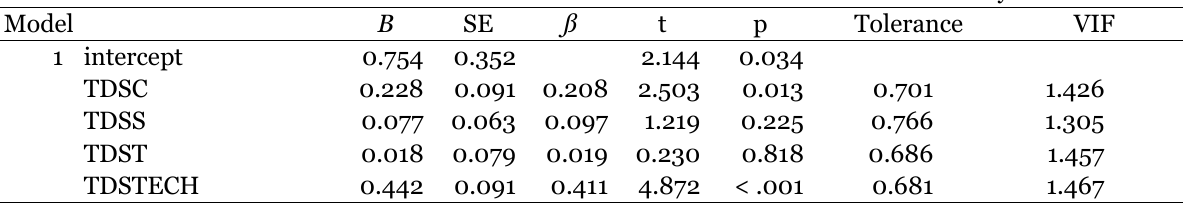
Collinearity statistics